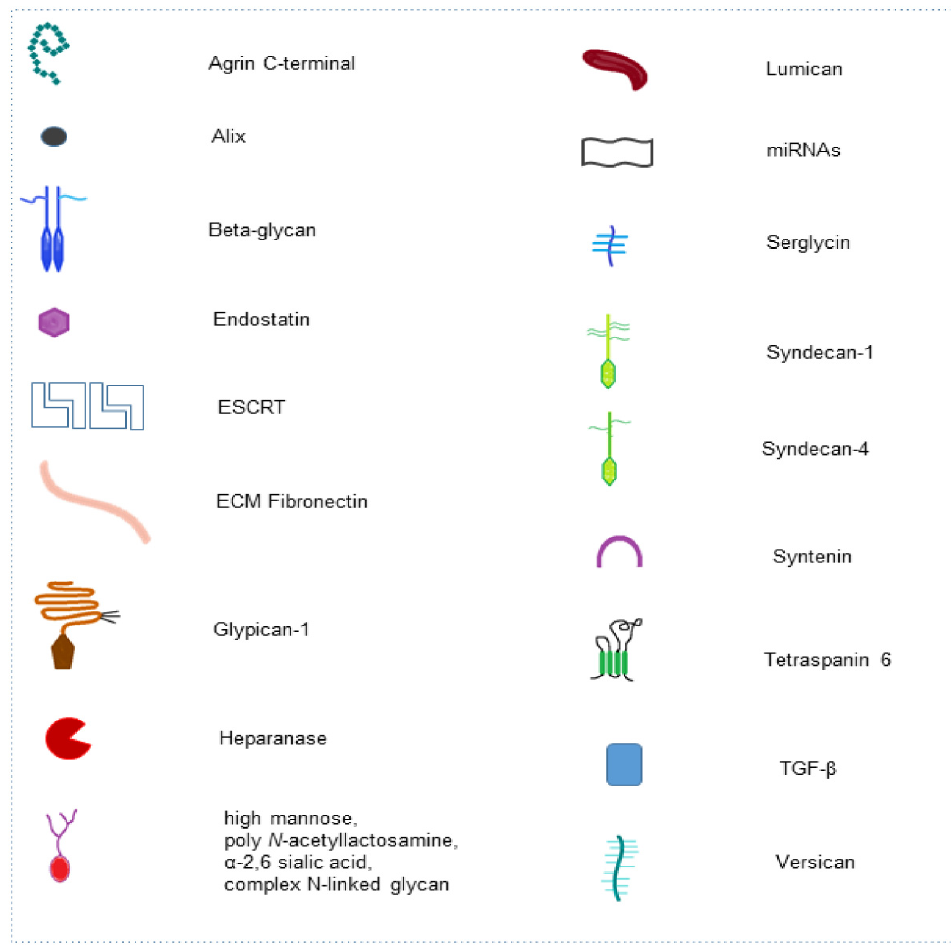
Figure A1. Map legend of glycans and other molecules of EXO cargo, for good interpretation of Figures 1 and 2. Agrin C-terminal, Alix, Betaglycan, Endostatin, ESCRT, ECM Fibronectin, Glypican-1, Heparanase, polysaccharides (high mannose, polylactosamine, α -2,6 sialic acid, complex N-linked glycan), Lumican, miRNAs, Serglycin, Sindecan-1, Sindecan-4, Syntenin, Tetraspanin-6, TGF- β , Versican.